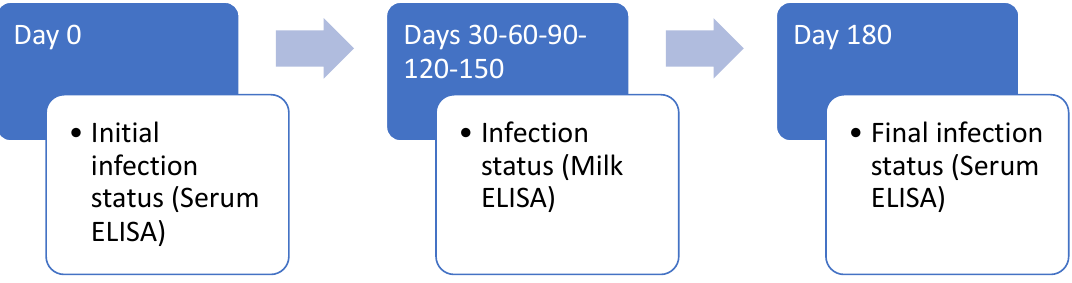
Figure 1. Follow-up process for identification of new infected cases in adult cows.